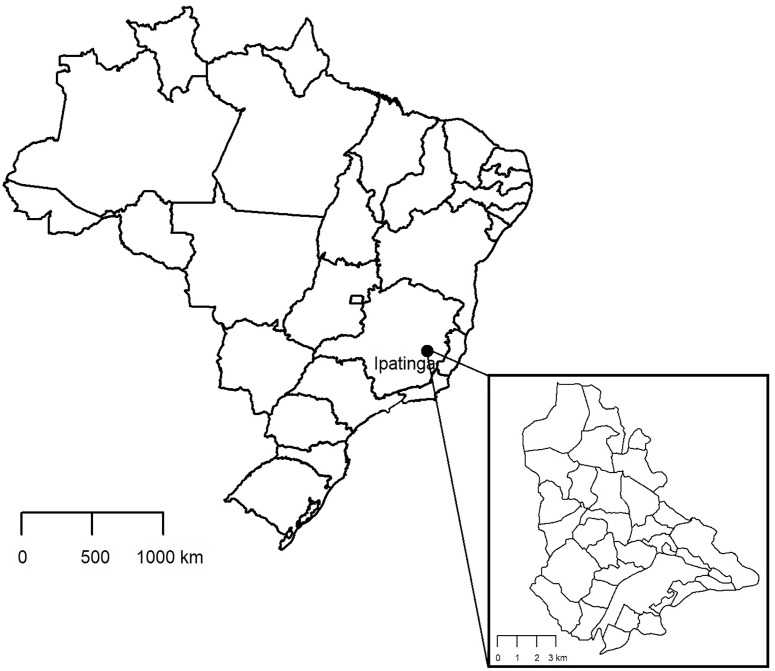
Geographic location of the city of Ipatinga in the Brazilian state of Minas Gerais.Ipatinga (black dot) is the main urban center in the region known as Steel Valley, due to the local settlement of large international steel-producing companies. Inset: Map of the city of Ipatinga with district subdivision.